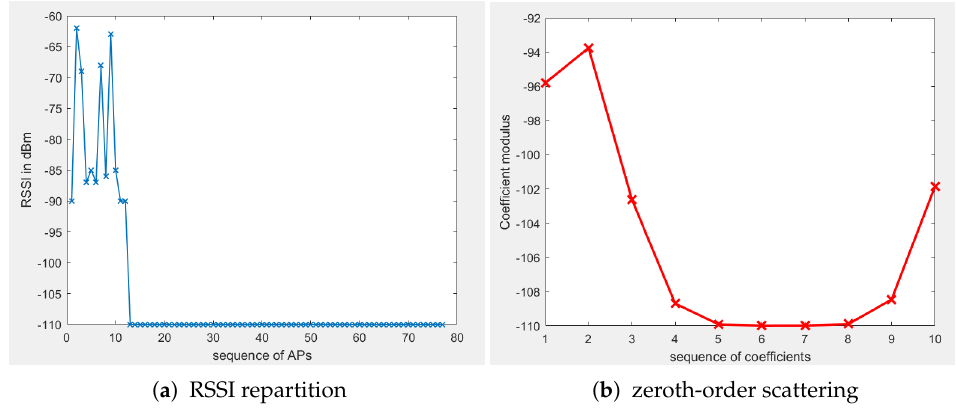
Figure 3. RSSI and its zeroth-order scattering